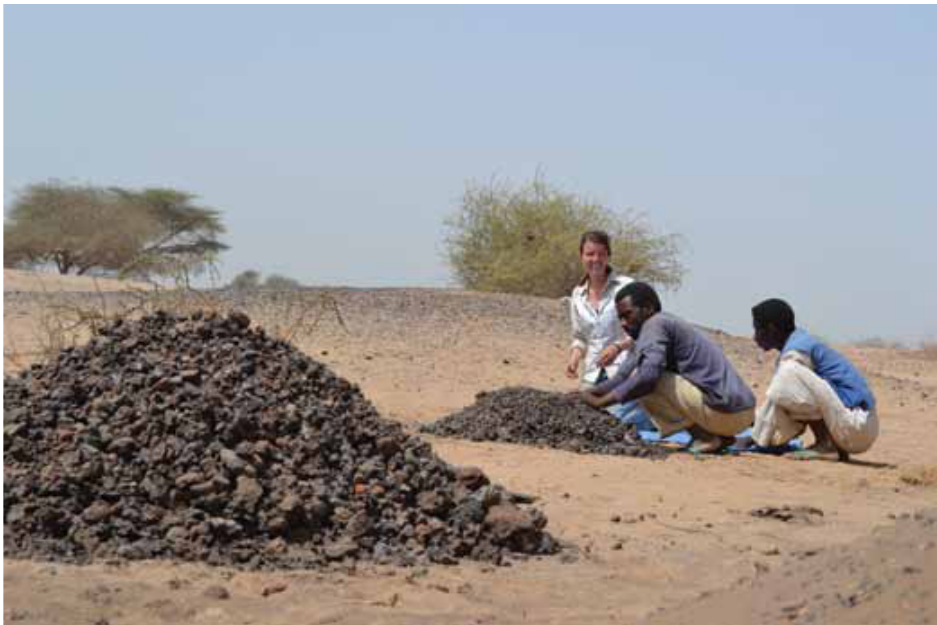
Fig. 1: Sorting iron smelting slag at a UCL Qatar excavation in